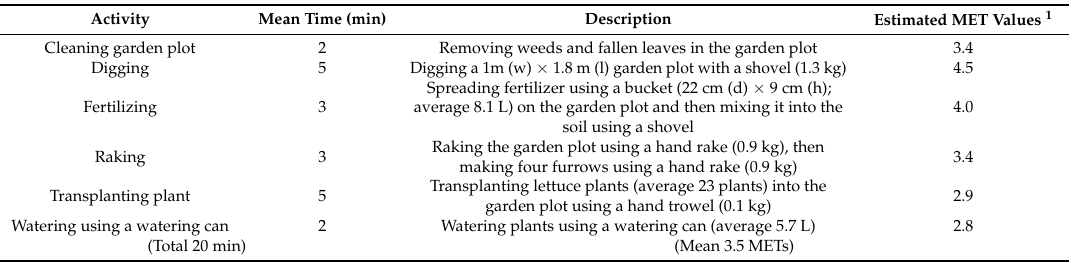
Table 1. Gardening activities, making an vegetable garden plot performed by the subjects in the study of benefits gardening activities for memory according to measurement of brain growth factor